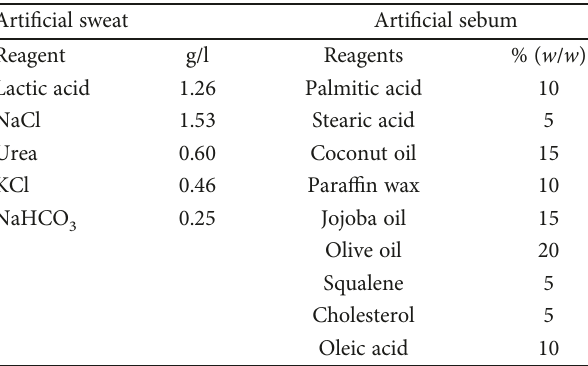
Table 2: Components of the arti fi cial sweat and their concentrations in g/l and of arti fi cial sebum and relative % w / w